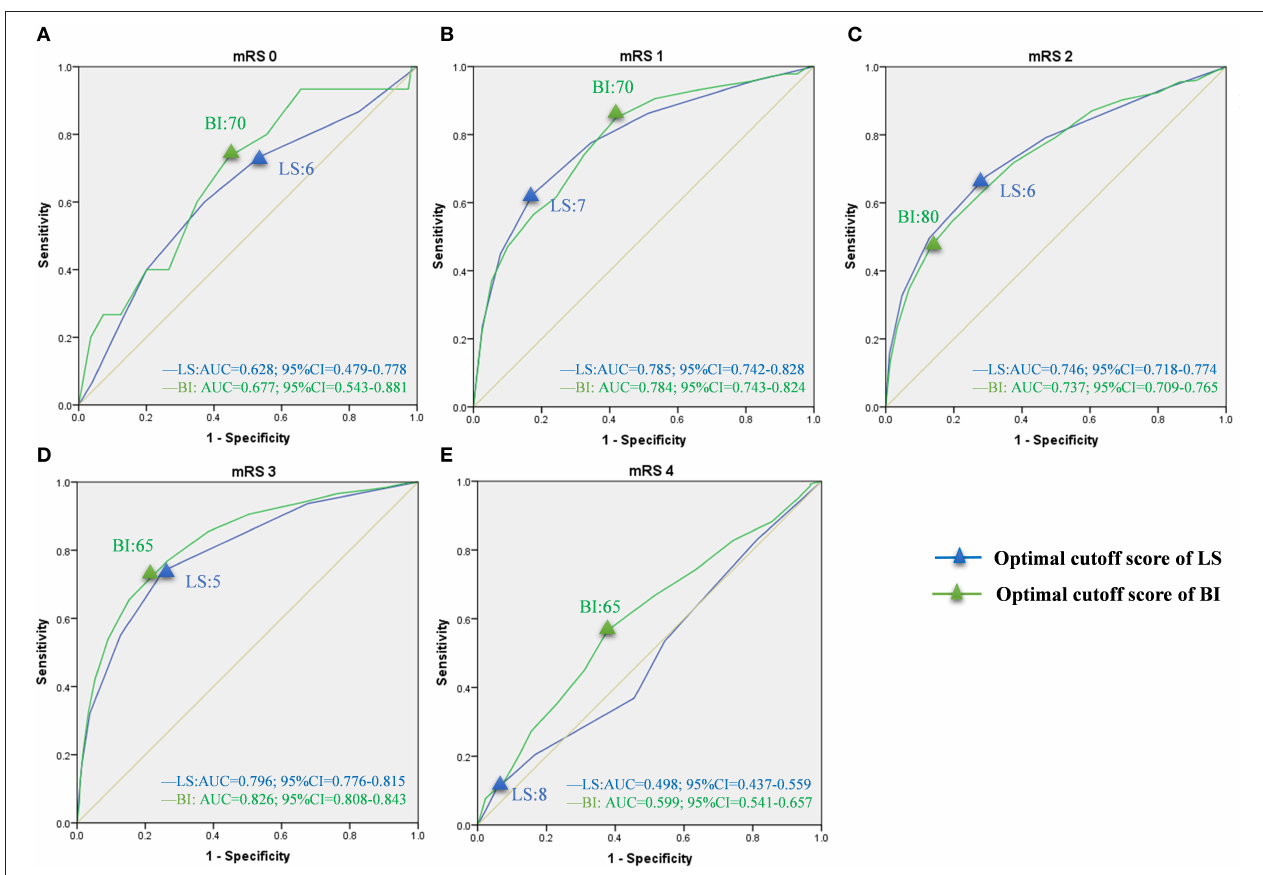
FIGURE 4 | ROC curves of LS and BI cutoff scores corresponding to mRS grades in the domestic group. LS, Longshi Scale; BI, Barthel Index Scale; mRS, modified Rankin Scale; ROC, Receiver Operating Characteristic; AUC, Area Under Curve; CI, Confidence Interval. (A) ROC curves for LS and BI cutoff scores in mRS 0. Optimal cutoff score: 6 and 70; Sensitivity: 60.0 and 73.3%; specificity: 62.8 and 55.6%; AUC: 0.628 and 0.677, respectively. (B) ROC curves for LS and BI cutoff scores in mRS 1. Optimal cutoff score: 7 and 70; Sensitivity: 62.3 and 84.8%; specificity: 82.7 and 58.3%; AUC: 0.785 and 0.784, respectively. (C) ROC curves for LS and BI cutoff scores in mRS 2. Optimal cutoff score: 6 and 80; Sensitivity: 67.8 and 54.6%; specificity: 70.5% and 80.4%; AUC: 0.746 and 0.737, respectively. (D) ROC curves for LS and BI cutoff scores in mRS 3. Optimal cutoff score: 5 and 65; Sensitivity: 74.0 and 76.9%; specificity: 74.7 and 73.5%; AUC: 0.796 and 0.826, respectively. (E) ROC curves for LS and BI cutoff scores in mRS 4. Optimal cutoff score: 8 and 65; Sensitivity: 10.6 and 94.4%; specificity: 56.6 and 62.2%; AUC: 0.498 and 0.599,